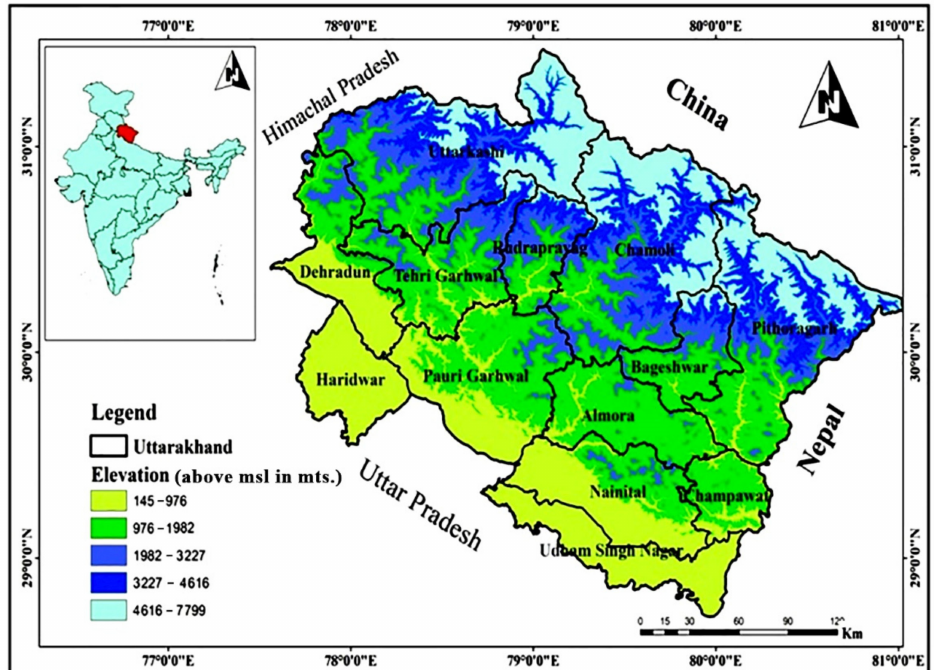
Figure 1. Location map of the Uttarakhand in